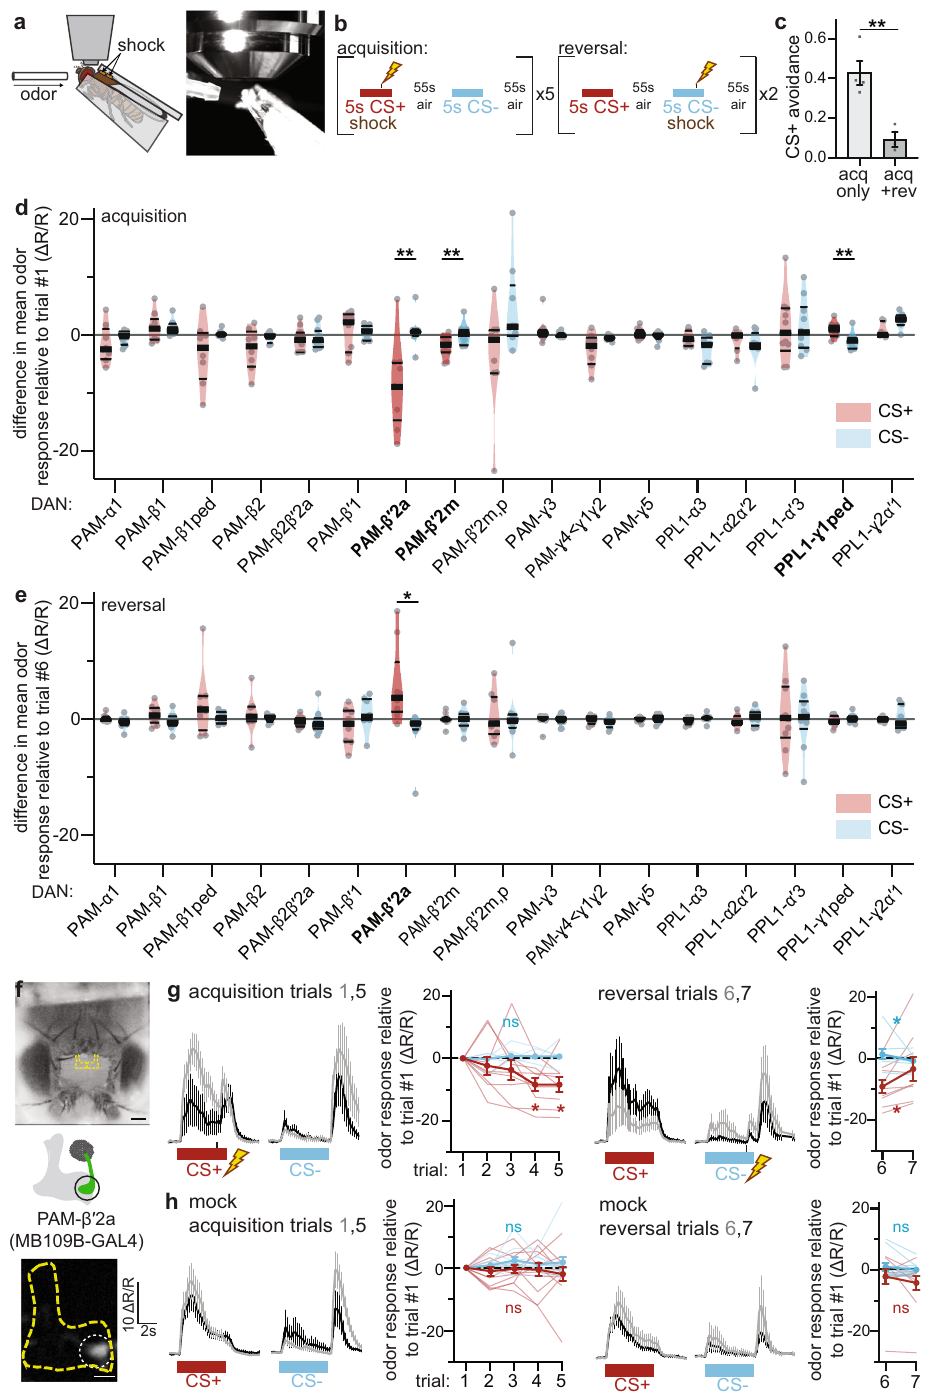
(Fig. 1d). PPL1- γ 1ped increases CS + odor response during acquisition, as previously observed 52 . No changes in CS − odor response occur in any DANs during acquisition. While PAM- β ′ 2a DAN decreases during acquisition, it increases CS + odor response during reversal (Fig. 1e). No other DANs change their odor responses during reversal; PAM- β ′ 2m and PPL1- γ 1ped retain their decreased and increased CS + odor response, respectively. PAM- β ′ 2a signi fi cantly decreases its CS + odor response only after three acquisition trials, yet signi fi cantly increases its CS + odor response after a single reversal trial (Fig. 1f, g). This increase NATURE COMMUNICATIONS| (2021) 12:1115